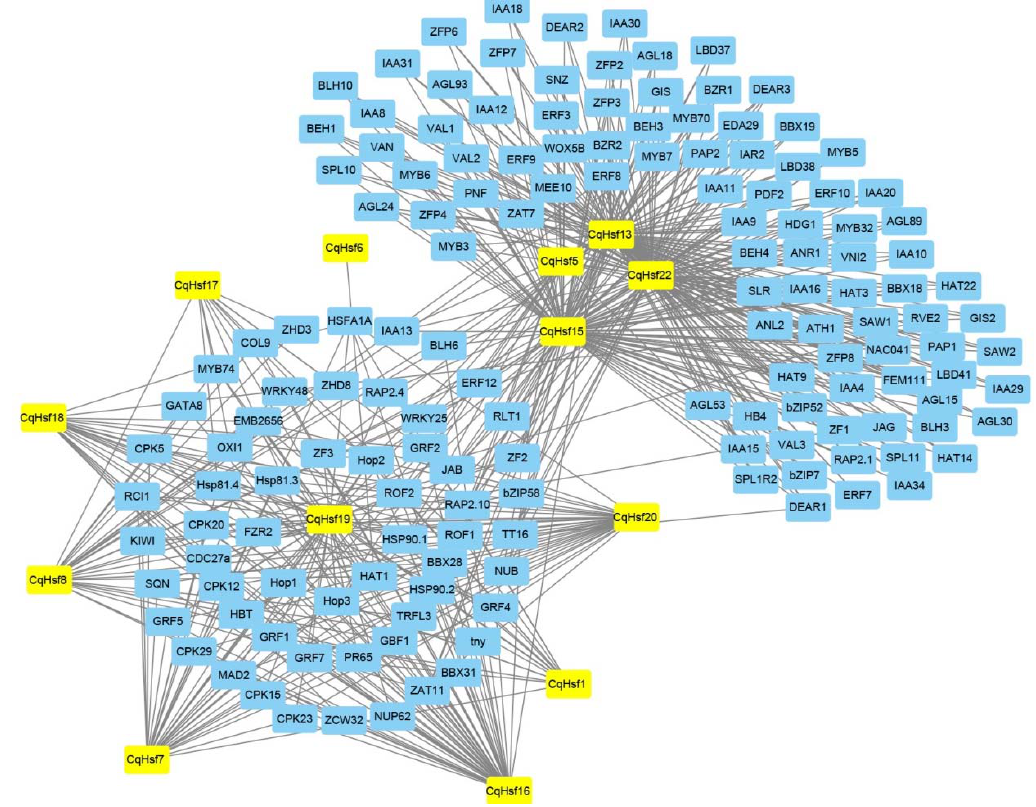
Figure 3. Interaction network of Hsf genes in quinoa.